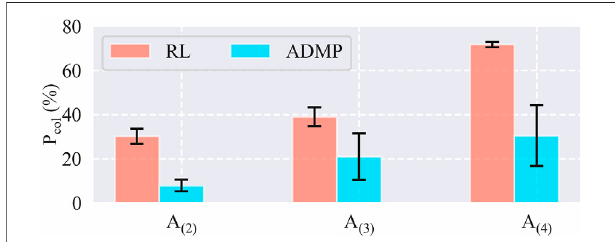
FIGURE 8 | Collision percentage during the training sessions.